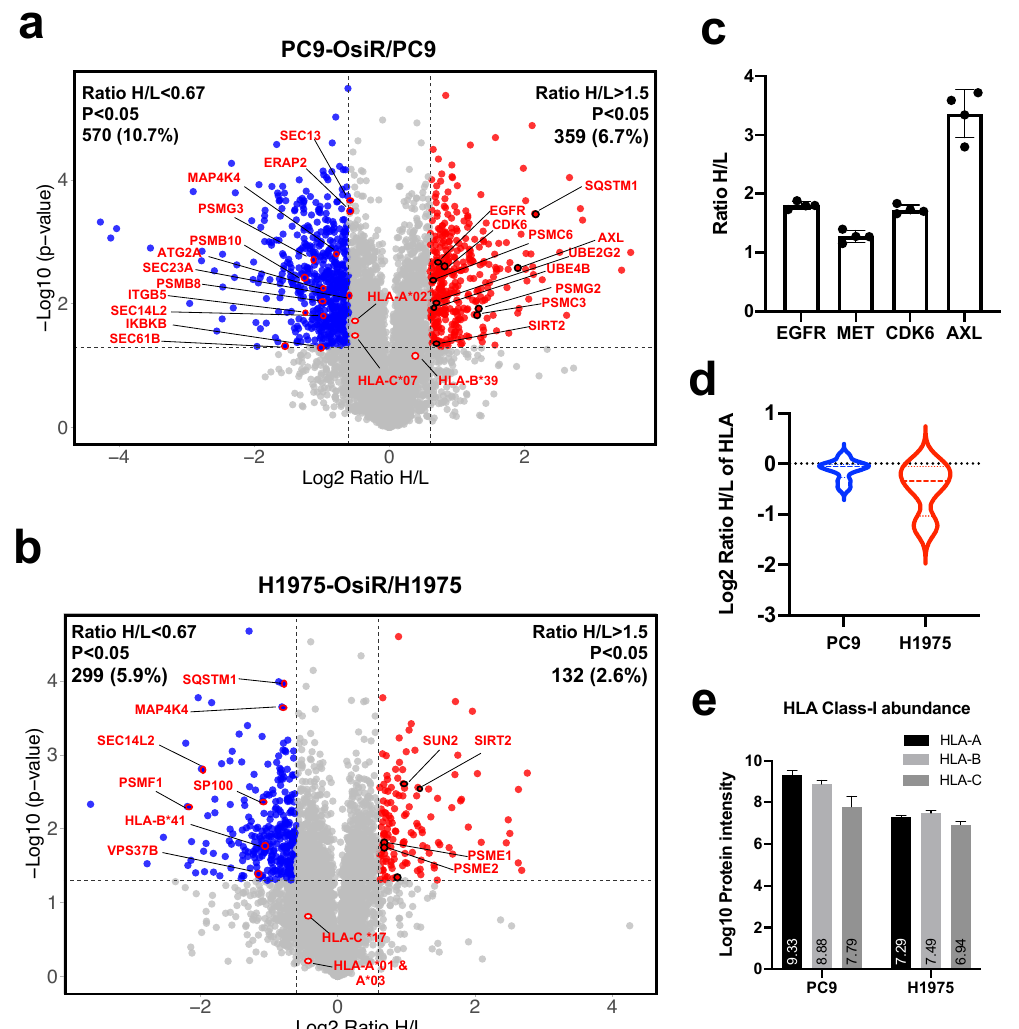
Figure 4. Total proteome analysis reveals the potential molecular mechanisms of overall reduced antigen presentation upon osimertinib resistance. ( a , b ) Volcano plots show the quantitative analysis of SILAC-labeled proteins in total proteome of PC9-OsiR/PC9 ( a ) and H1975-OsiR/H1975 lung adenocarcinoma cells ( b ). ( c ) Fold changes (Ratio H/L) of EGFR, MET, CDK6 and AXL in PC9-OsiR/PC9 cells. ( d ) Violin plot shows HLA class I protein expression in both cell lines. ( e ) Bar charts show the total protein abundance of HLA-A, HLA-B, and HLA-C in ( a ) Bar charts show the total protein abundance of HLA-A, HLA-B, and HLA-C in PC9 and H1975